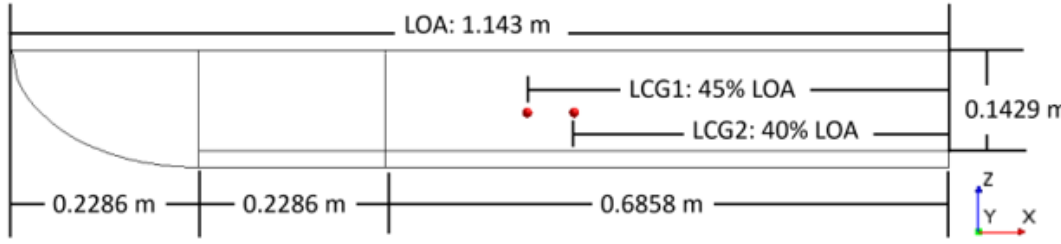
Figure 2. Key dimensions of studied hulls in the vertical plane.